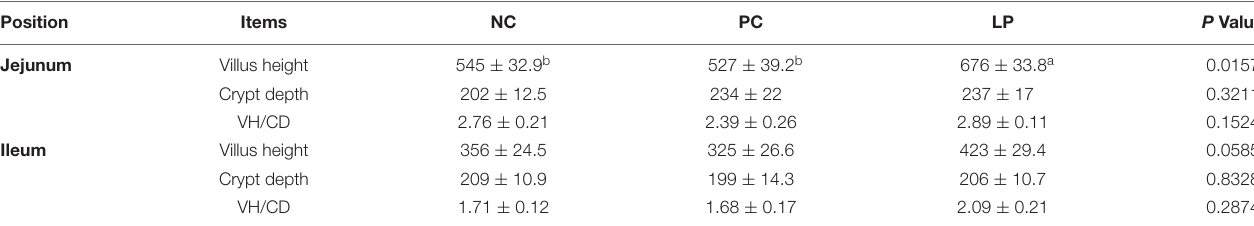
VH/CD, ratio of villus height to crypt depth. Different superscript letters within a row represent statistically significant differences among groups (P < 0.05).